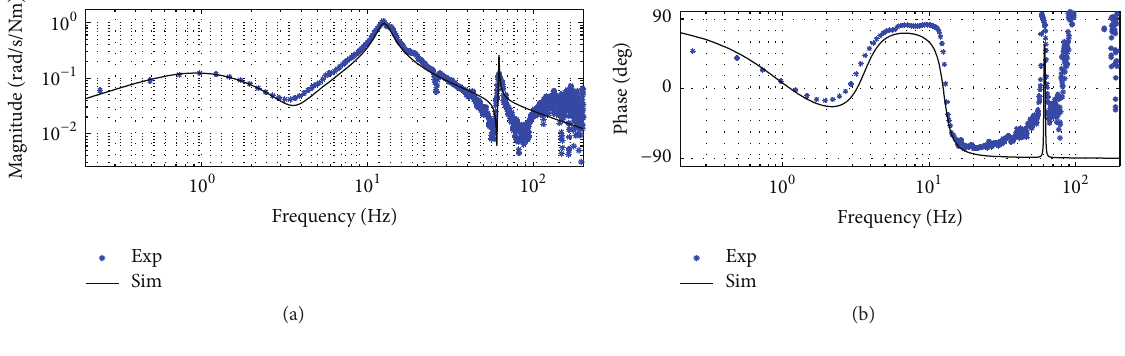
̇𝜃 /𝑇 5 5 : modulus (a) and phase (b).